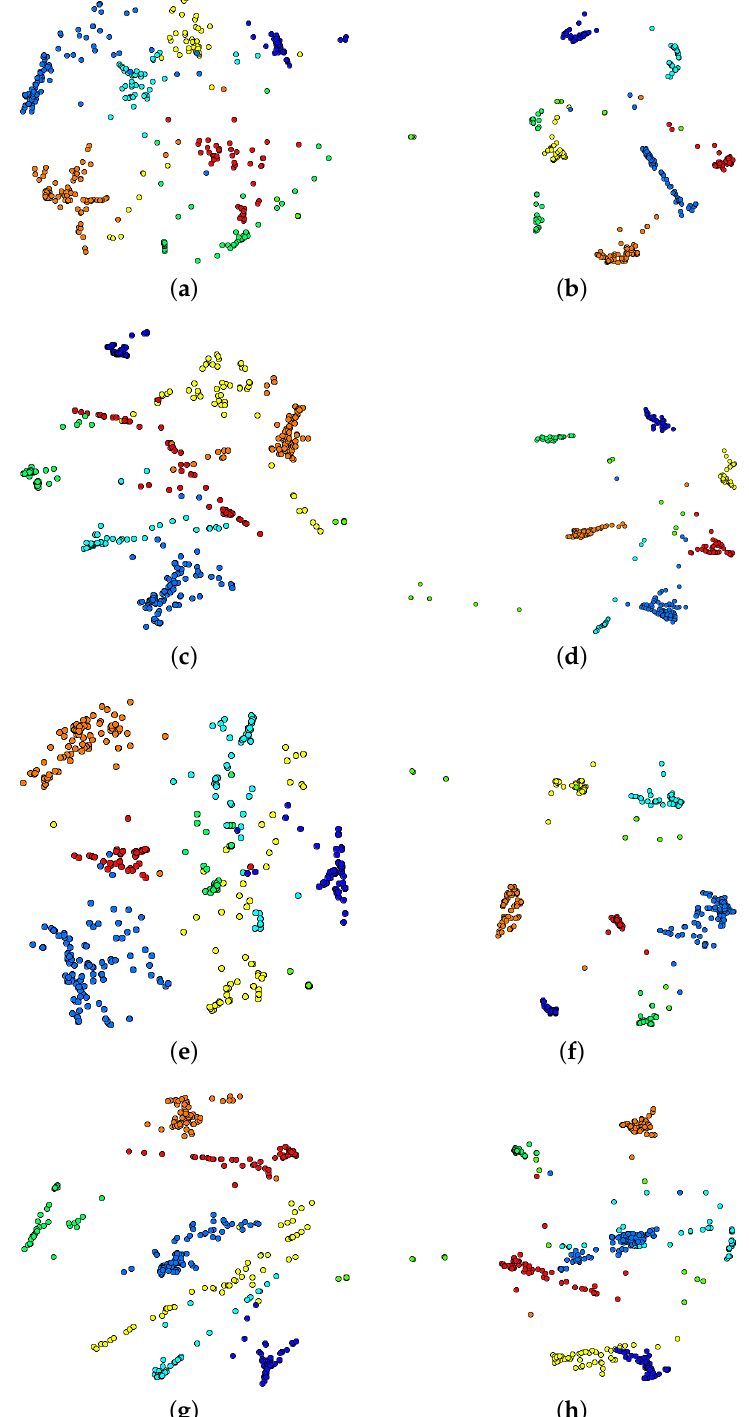
Figure 6. Projections models computed from the NEWS-8 dataset. The Least Squares Projection (LSP) [13] technique was employed to generate these graphical representations. ( a ) No stem-TF-IDF-LC1; ( b ) no stem-TF-IDF-LC51; ( c ) no stem-TF-LC1; ( d ) no stem-TF-LC51; ( e ) Porter stem-TF-IDF-LC1; ( f ) Porter stem-TF-IDF-LC51; ( g ) Porter stem-TF-LC1; ( h ) Porter